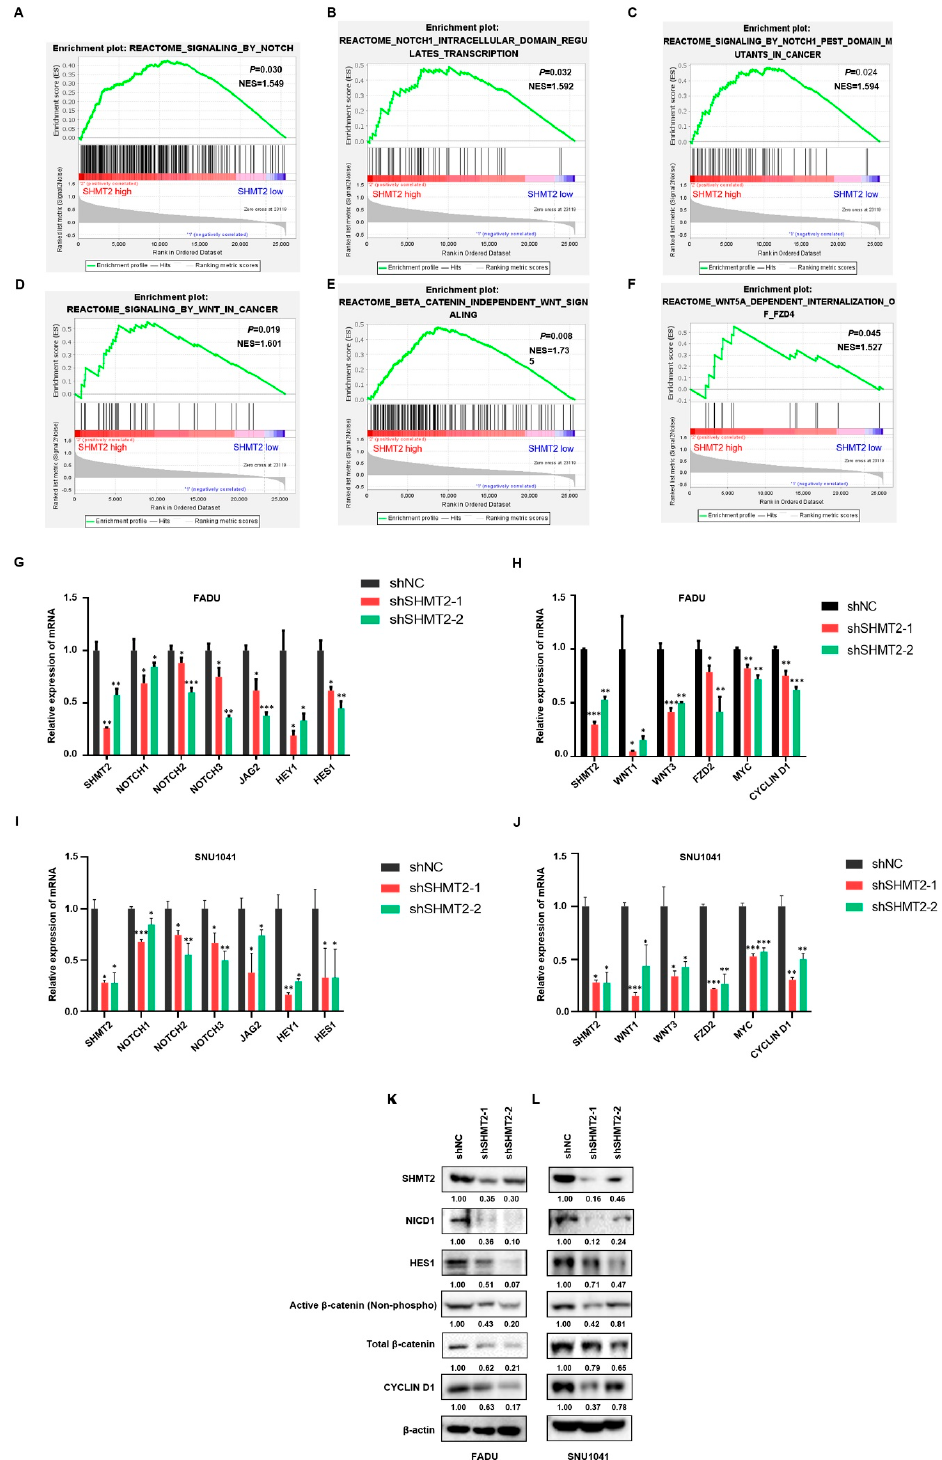
Figure 5. SHMT2 promoted stem cell-like properties by activating the Notch and Wnt signaling pathways in HNC. ( A – F ) Notch- and Wnt pathway-related gene sets were enriched in HNC patients with high SHMT2 expression in the TCGA dataset. ( G – J ) Reverse-transcription quantitative PCR analysis of Notch and Wnt pathway-related genes with SHMT2 knockdown in FADU and SNU1041 cells. ( K , L ) Western blot analysis of Notch and Wnt pathway-related proteins with SHMT2 knock- down in the FADU and SNU1041 cells. Differences were considered significant at p < 0.05 (* p < 0.05, ** p < 0.01, *** p <